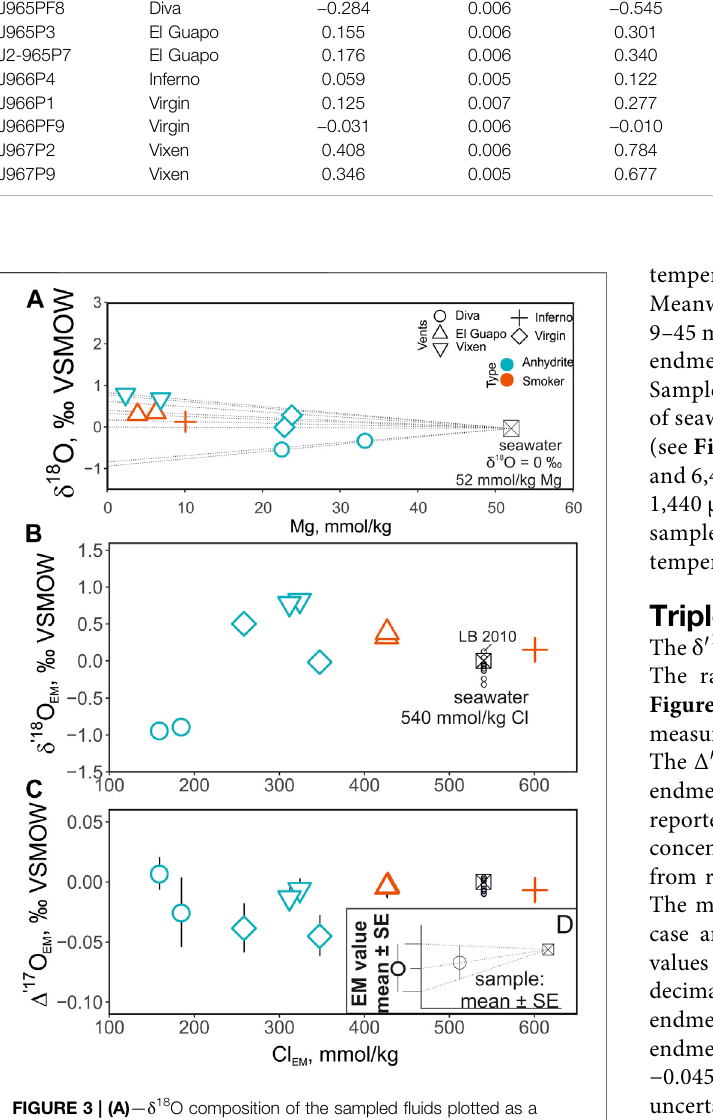
FIGURE 3 | (A) — δ 18 O composition of the sampled fl uids plotted as a function of Mg concentration. The points are color-coded by the vent type. The dashed lines show interpolation of the triple oxygen isotope values from seawater (Mg (cid:1) 52 mmol/ kg) to endmember compositions (0 mmol/ kg)based oneach ventsite. Thepanels (B,C) showthezero-Mg endmember (hence subscript EM) values of vent fl uids ’ Cl concentrations and O isotopes. Note the change in the vertical axis scale. The small black circles labeled LB2010 are direct measurements of seawater (data from Luz and Barkan, 2010). The values are shown only for deep seawater samples ( > 1000 m) to eliminate the effects of surface processes (e.g. evaporation). The panel (D) shows the methodology of propagating the uncertainty in the endmember